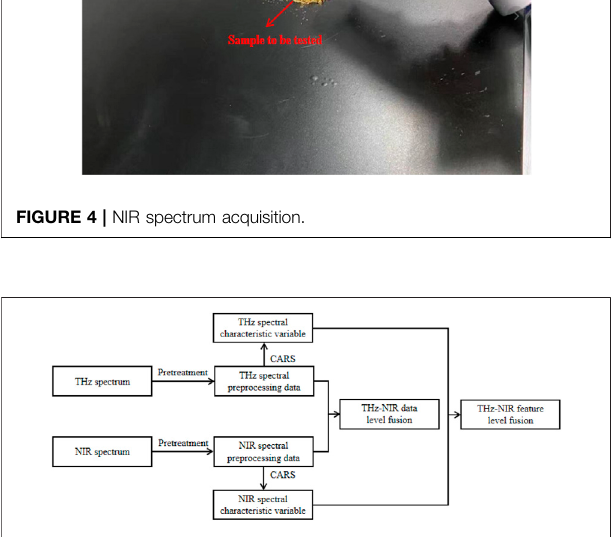
FIGURE 5 | Fusion